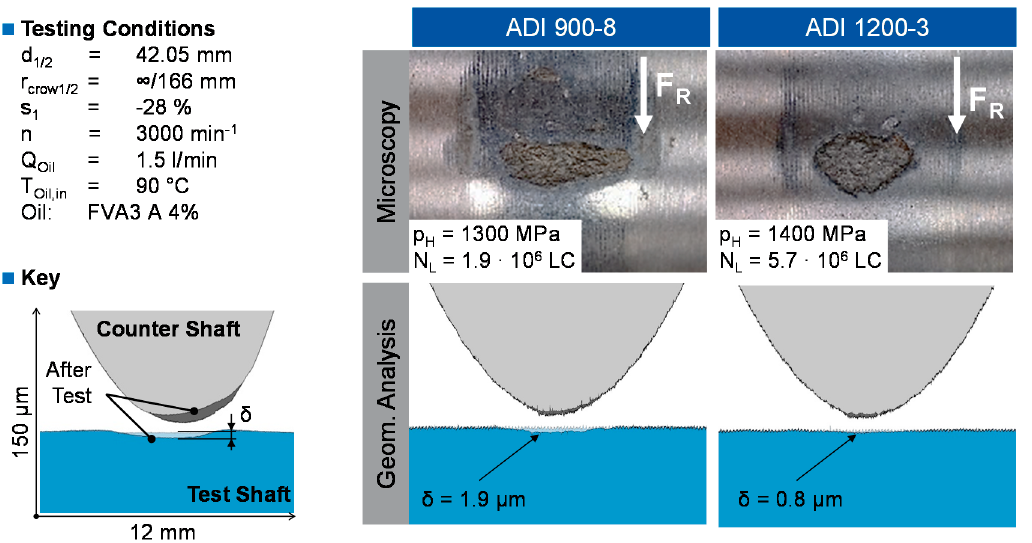
Figure 7. Analysis of the damage pattern and geometrical changes.